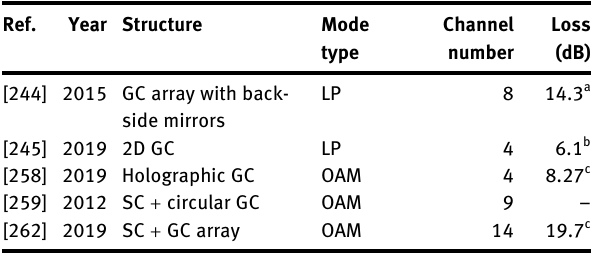
Table  : Survey of experimentally demonstrated multi-mode (de)multiplexers on SOI.